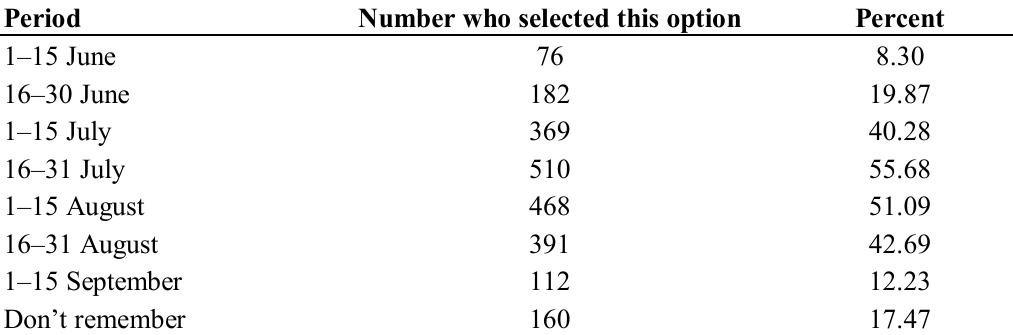
Table 5. Respondent-reported heat episodes in summer